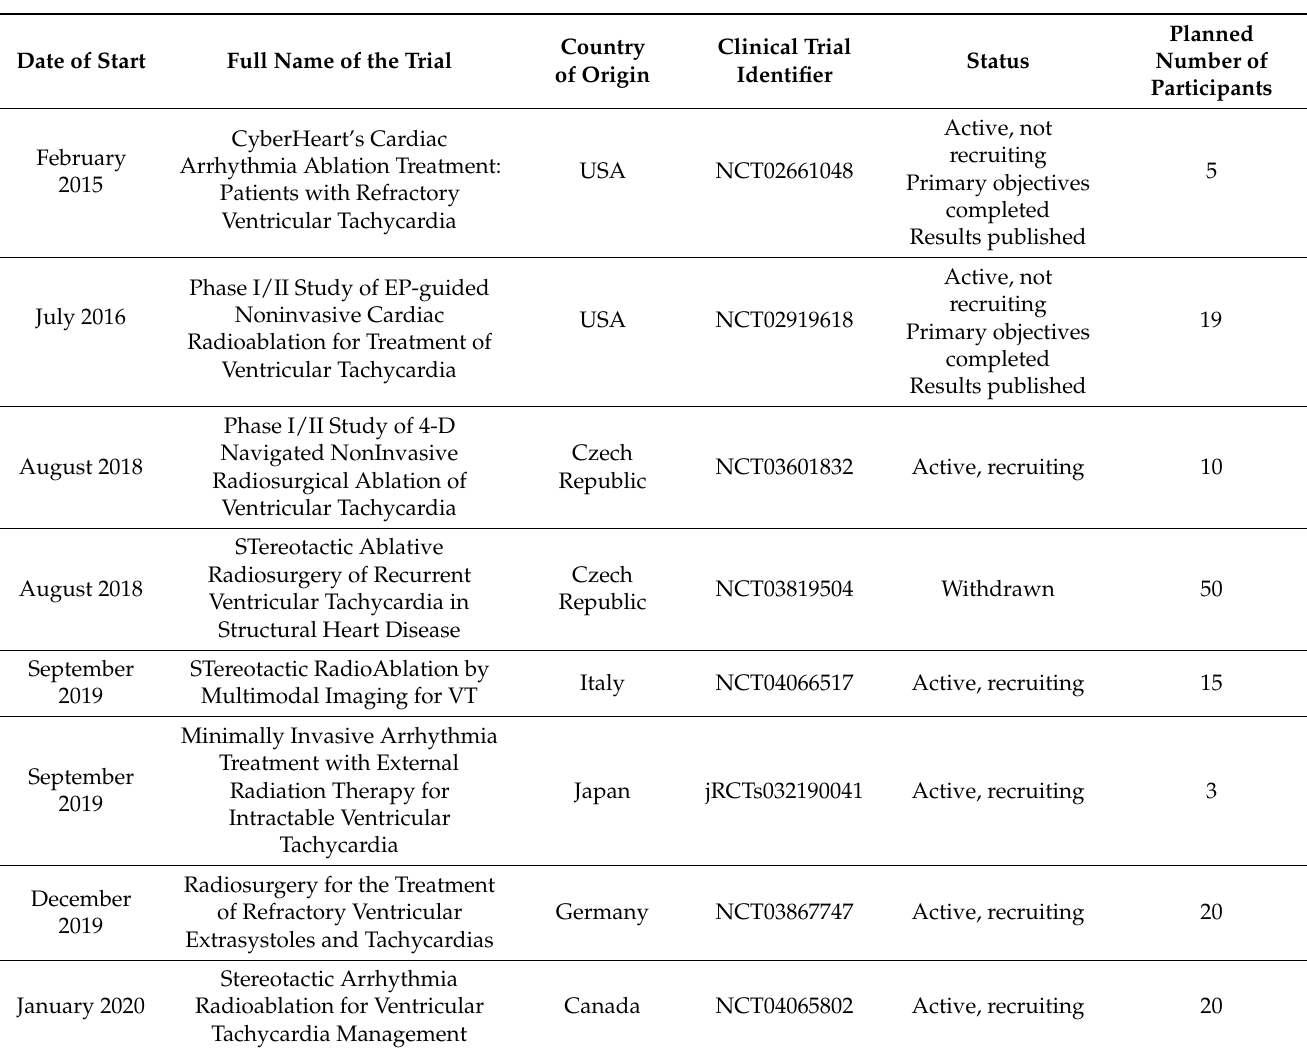
Table 3. Ongoing clinical